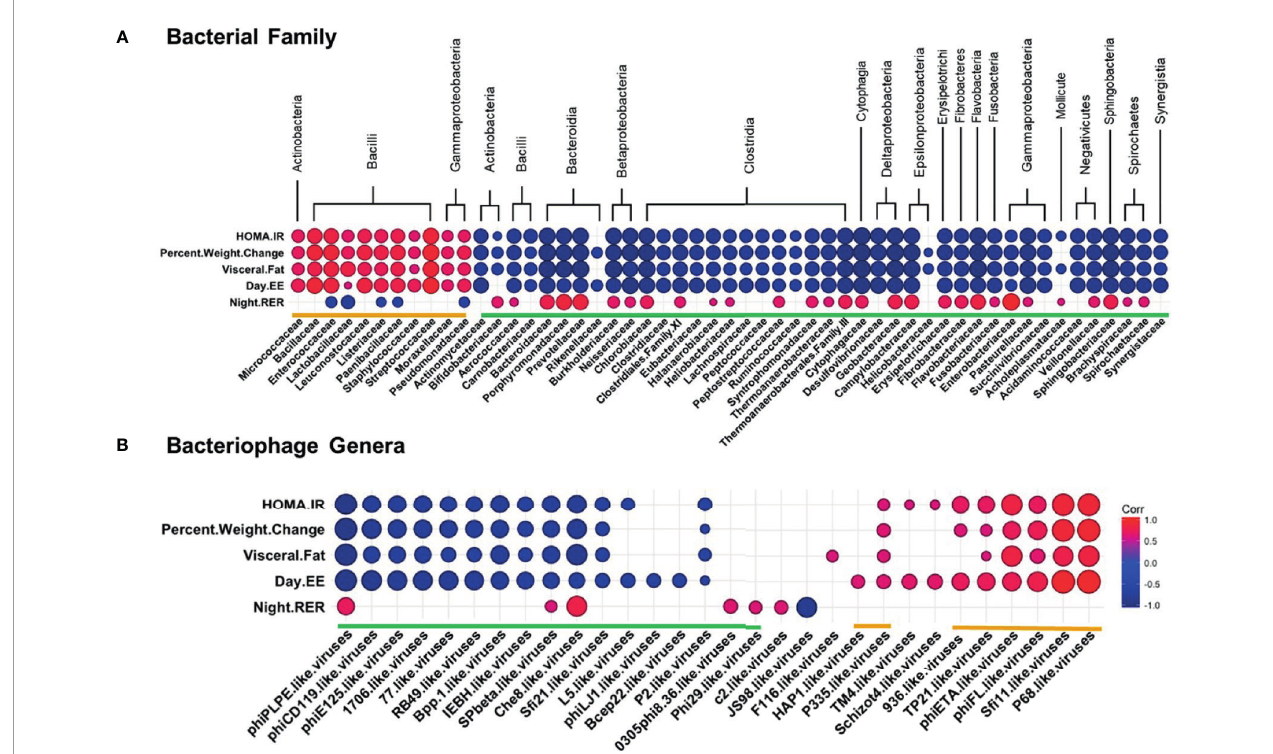
FIGURE 8 | Diet Induced Bacteria/Bacteriophage – Metabolic Patterns in Obesity. Pearson ’ s correlation plot of (A) Bacterial Families (top 55 most abundant) or (B) Bacteriophage Genera (Viral OTUs within the order Caudovirales) and metabolic parameters for mice fed Chow or WD for data after 12 weeks of dietary exposure. Statistical signi fi cance was determined for all pairwise comparisons. Positive values (red circles) indicate positive correlation coef fi cients above 0.6, and negative values (blue circles) indicate inverse correlation coef fi cients below -0.6. The size and shading of the circles indicate the magnitude of the correlation, where darker shades indicate a stronger correlation than lighter shades. Correlation coef fi cient values outside of the threshold of 0.6 are not included in this plot ( Tables S10 , S11